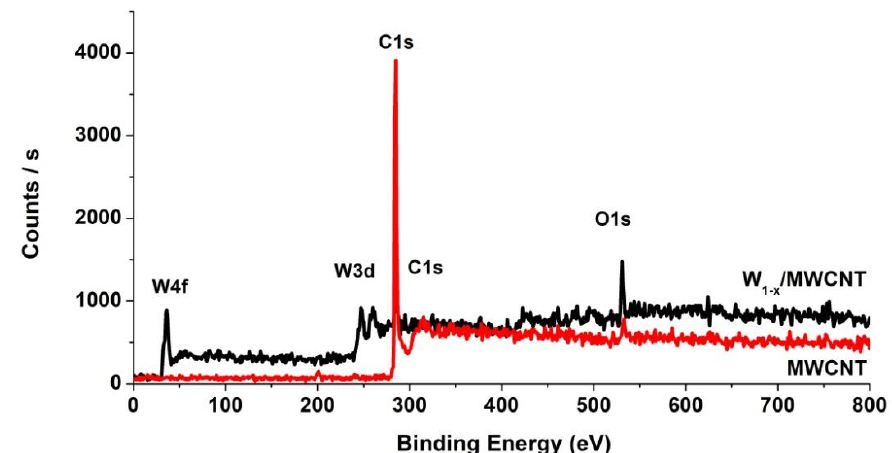
Figure 8. The X-ray photoelectron spectroscopy (XPS) spectra of the WC 1-x / MWCNTs sample 2 (black) and initial MWCNTs (red) in a wide energy range.